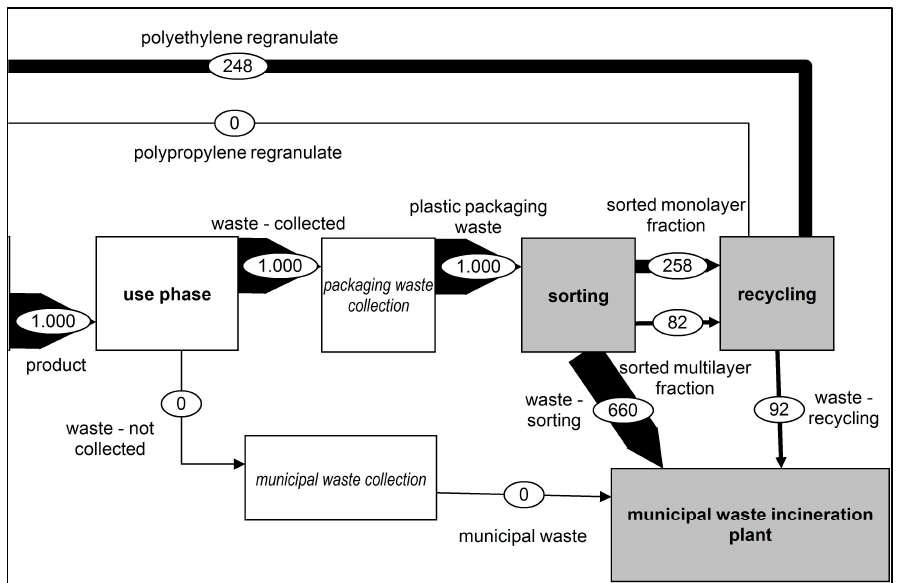
Figure 4. Representation of the changed material flows—Scenario 2.